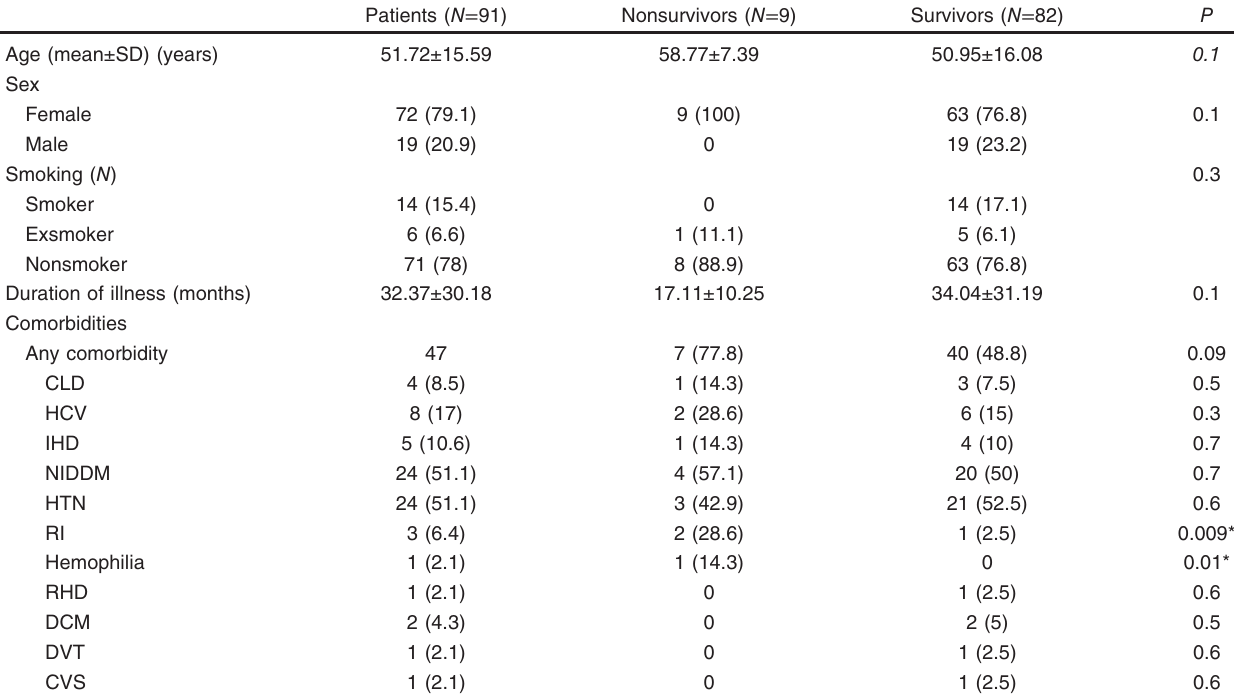
Table 1 Comparison between survivors and nonsurvivors as regards demographic